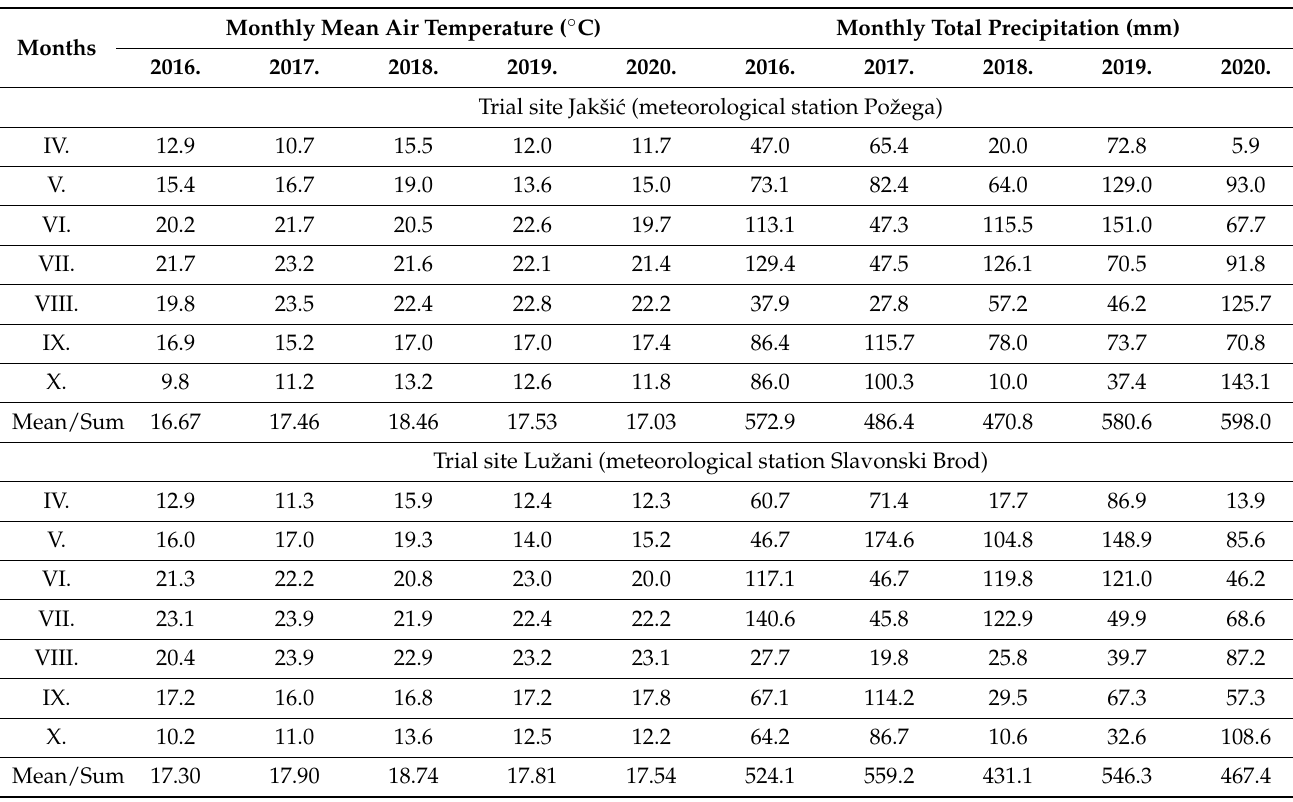
Table 1. Mean air temperature ( ◦ C) and total monthly precipitation (mm) at the trial site Jakši´c (meteorological station Požega) and Lužani (meteorological station Slavonski Brod)